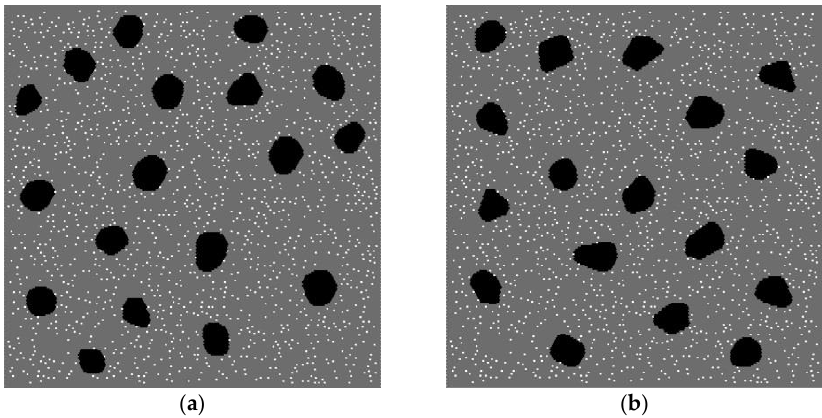
Figure 9. Examples of mesoscale water-saturated concrete samples with different spatial arrange- ments of aggregates and the same arrangement of micropores. Different initial values of the generator of random number were used to arrange aggregates in ( a , b ). The sample ( a ) is char- acterized by a slightly more uniform spatial distribution of aggregates and higher com-pressive strength in comparison with ( b